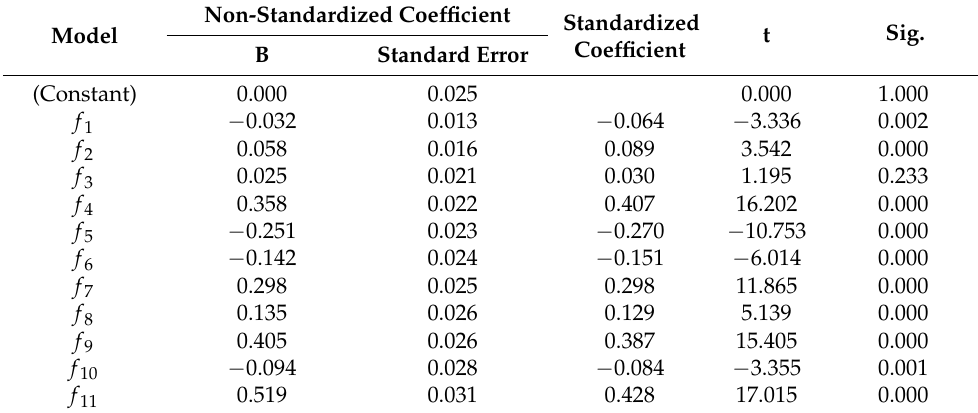
Table 7. Principal component linear regression coefficient.